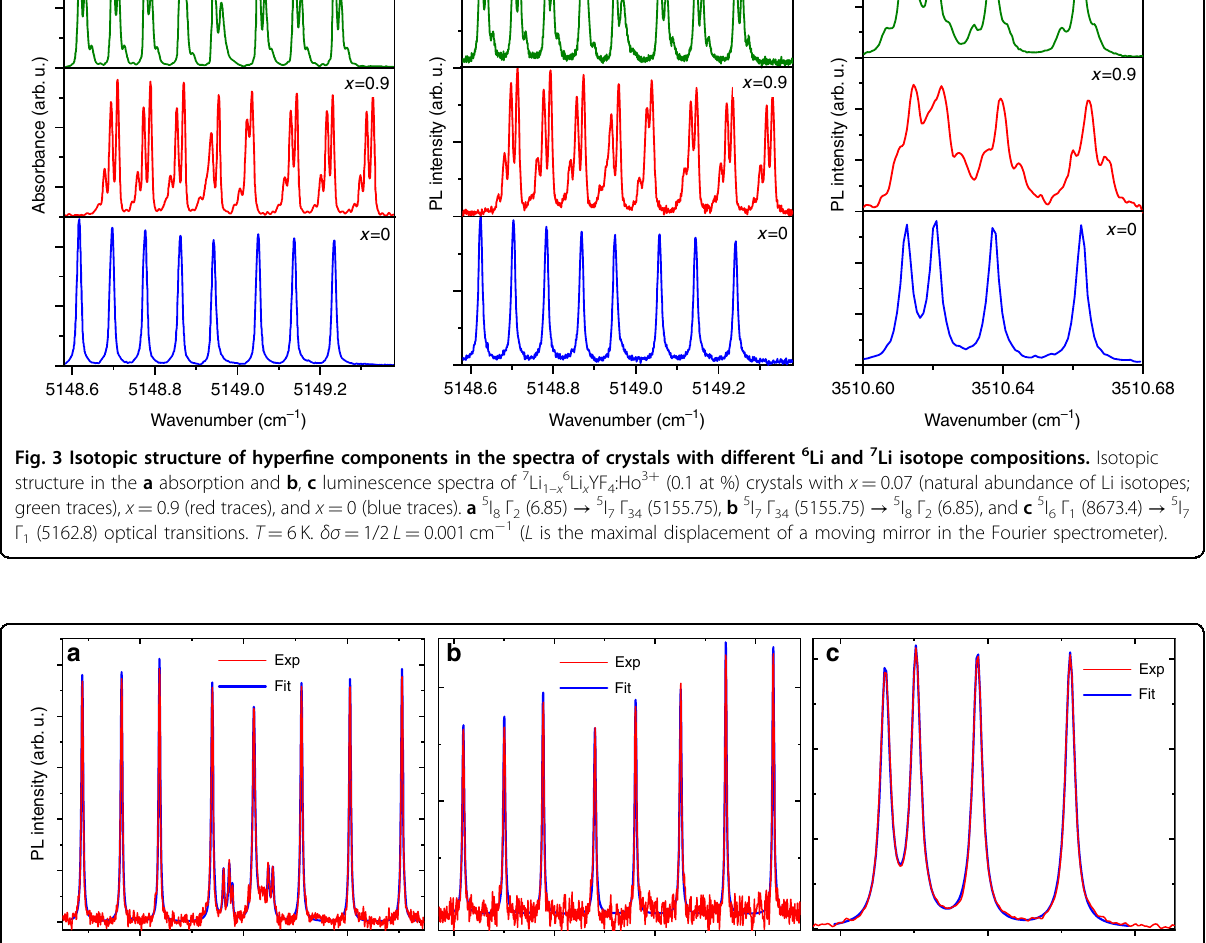
Г singlet of the ground 5 I CF multiplet, 5 I (6.85 cm − 1 ). 8 8 2 The presented picture coincides with the one observed in the absorption spectra at the corresponding transition 33 and demonstrates gaps at the anticrossings of the | Γ , m > 4 and | Γ , m ± 2> states (| Δ m | = 2) (see, e.g., a “ huge ” gap at 3 5149.0 cm − 1 in Fig. 6a) and of the | Γ , m > and | Γ , m > 4 3 states (| Δ m | = 0). However, it should be noted that when measuring luminescence, a better contrast is achieved. Narrowest PL lines of 7 LiYF CF :Ho 3 + (0.1 at. %) in a 7 4 → 5 I magnetic fi eld were observed in the case of the 5 I 6 7